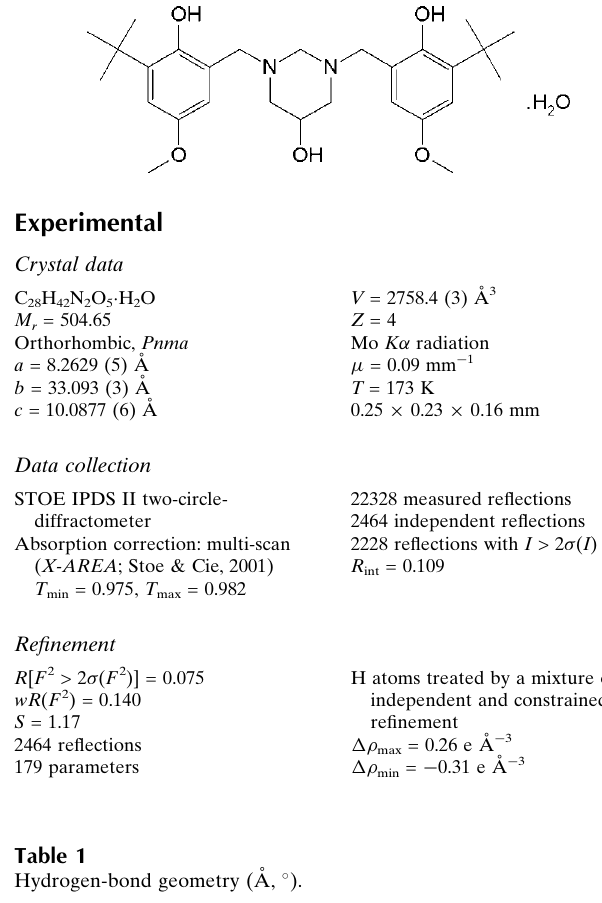
Hydrogen-bond geometry (A˚ , (cid:3)